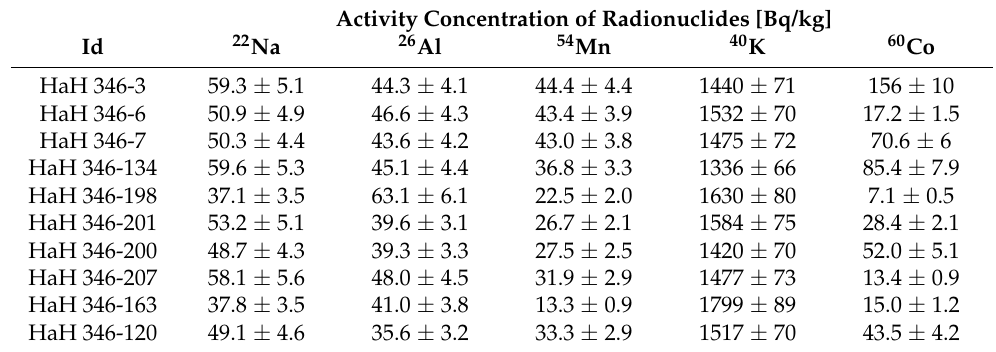
Table 3. Short-lived radionuclides 22 Na, 54 Mn, 60 Co and long-lived radionuclides 40 K, and 26 Al activity in various HaH 346 specimens.